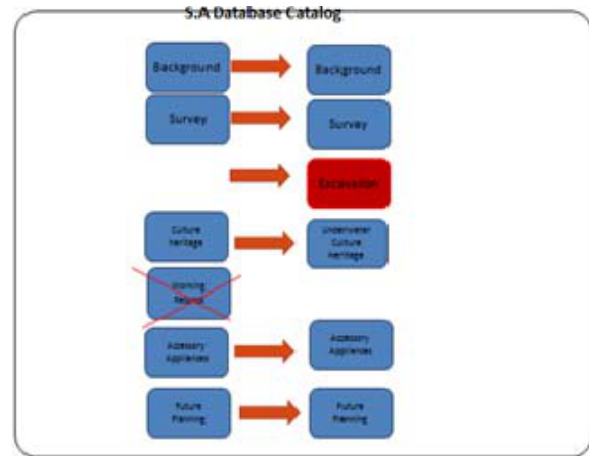
Figure 7. The database